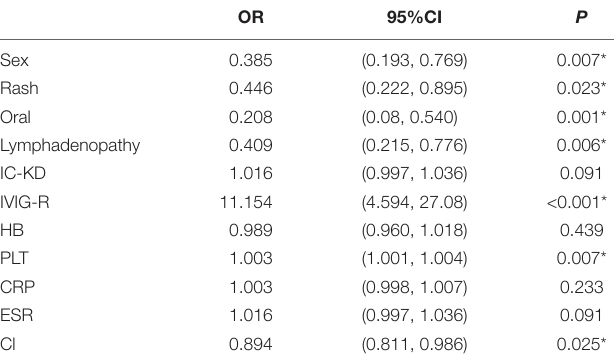
TABLE 2 | Multivariate logistic regression according to CAA.